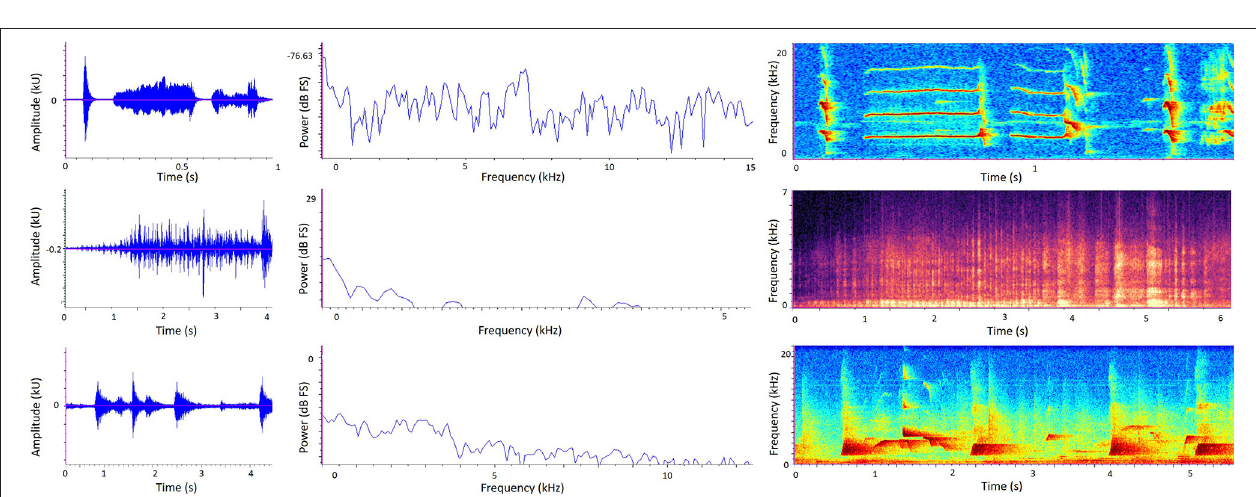
FIGURE 2 | A summary of sound. Panel 1: three sources of sound. Panel 2: environmental interference with sound. Panel 3: how animals hear. * Based on (14).